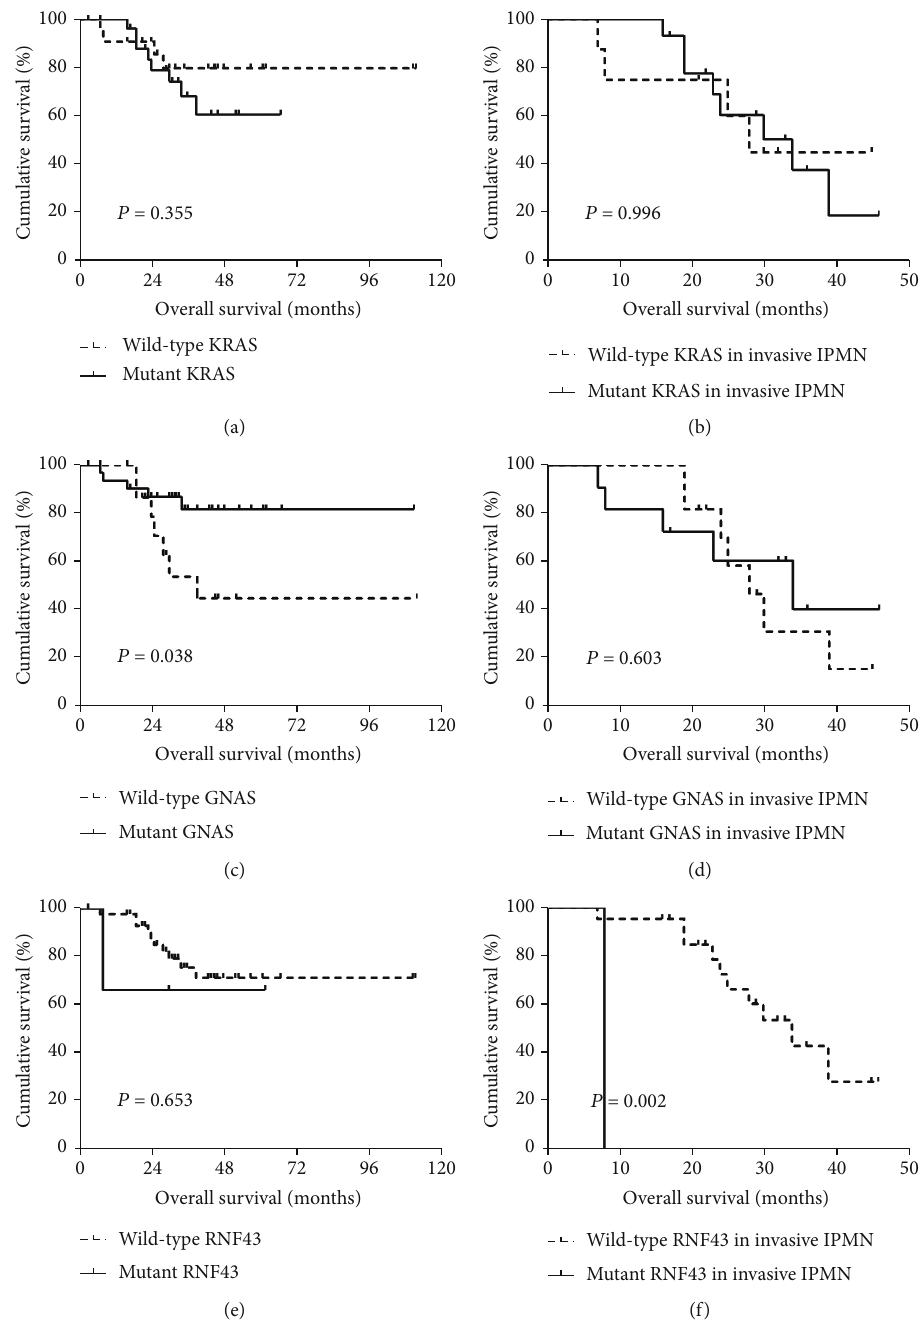
Figure 2: Kaplan-Meier survival analysis of IPMN patients based on the mutation status of